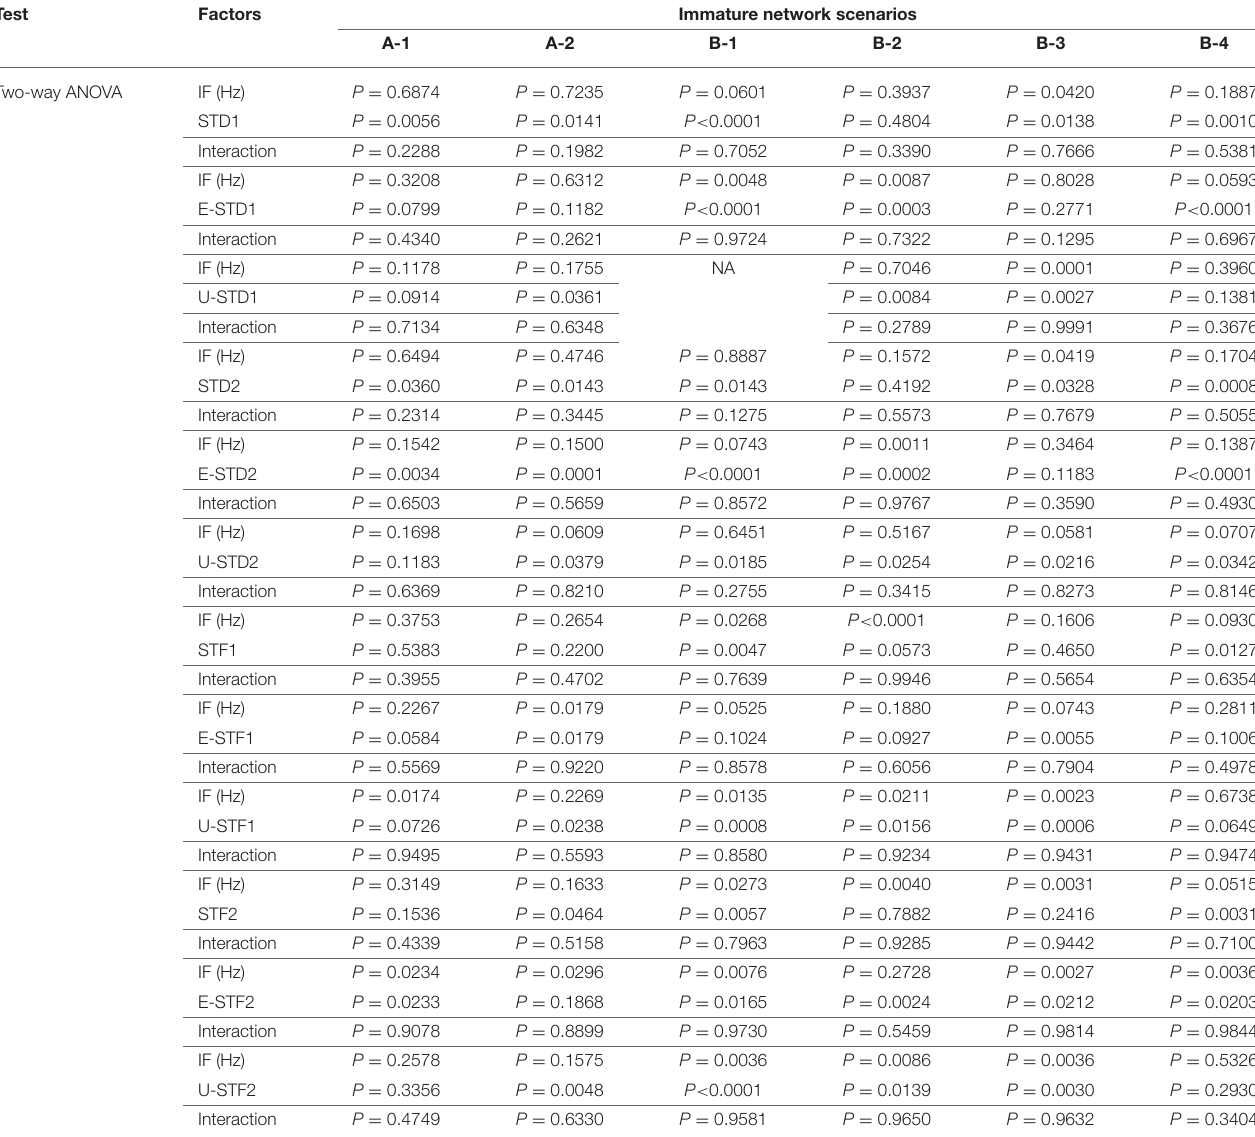
TABLE 5 | Two-way ANOVA for immature network scenarios. Test Factors Immature network scenarios